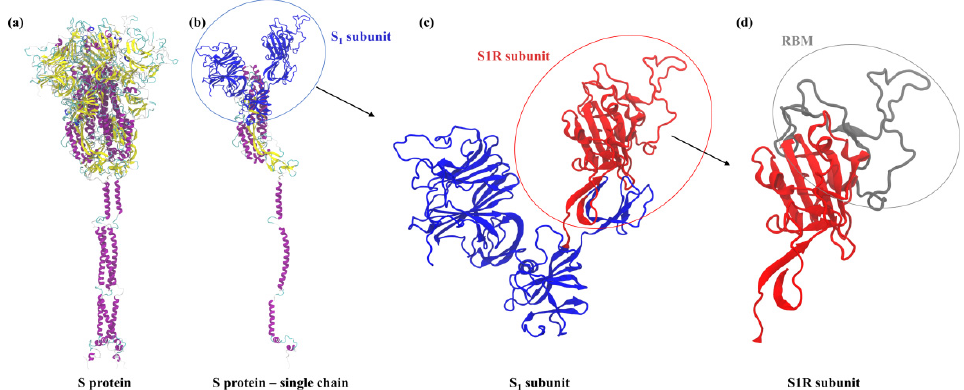
Figure 1. ( a ) Snapshot of S protein with highlighted secondary structure types. ( b ) Single chain of S protein with S1 subunit marked in blue. ( c ) The fragment of the S1 subunit with the receptor binding domain (S1R) marked in red. ( d ) Zoom of S1R domain with receptor binding motif (RBM) marked in grey. VMD software was used for visualization [21].